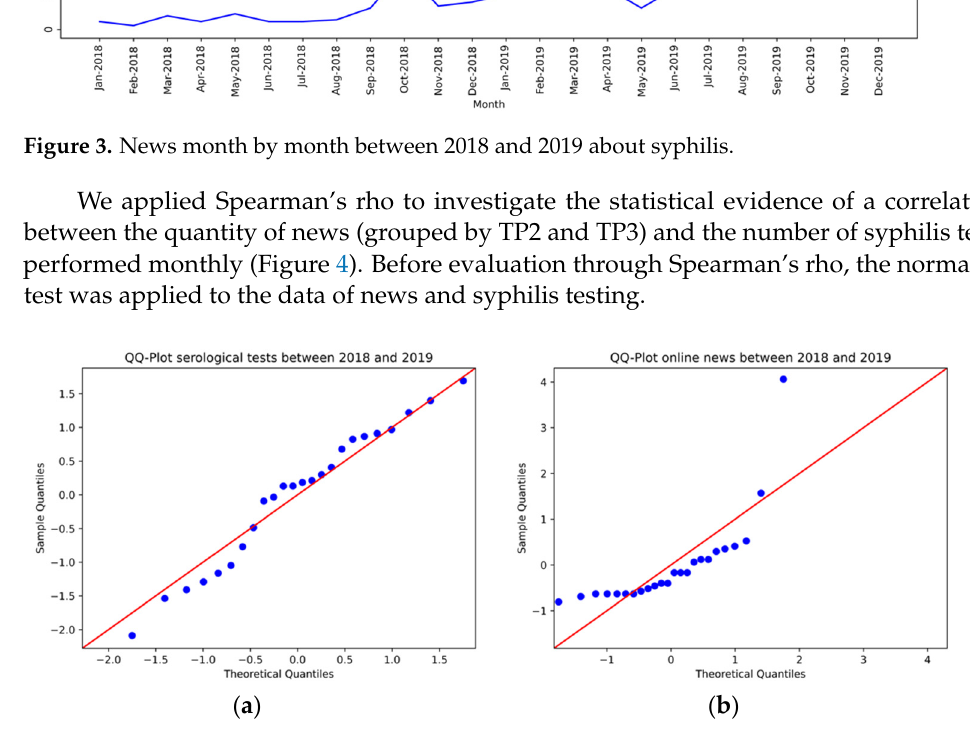
Figure 4. QQ-Plot of ( a ) syphilis testing and ( b ) online news items between 2018 and 2019.